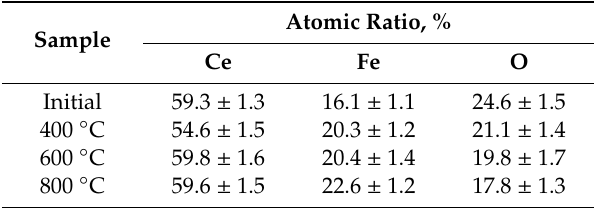
Table 1. Elemental composition data of studied nanoparticles.